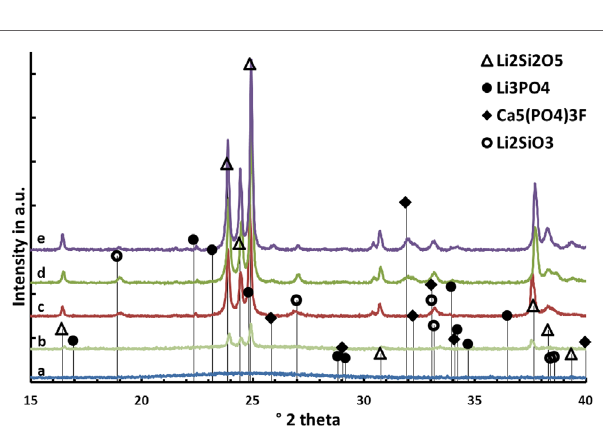
FigUre 3 | Diffractograms of glass D after (a) nucleation at 500°c for 30 min and after additional heat treatments at (b) 540°c, (c) 600°c, (d) 700°c, and (e) 800°c for 30 min each .